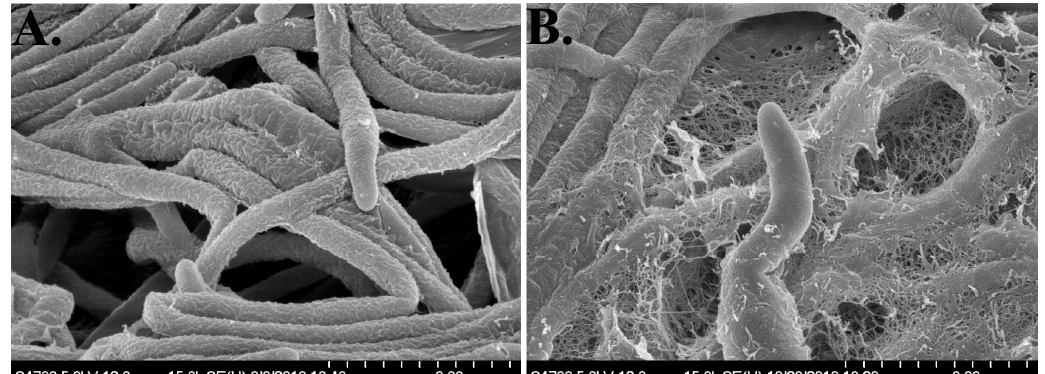
Figure 6. SEM images of actinobacterial-like structures from Iron Curtain Cave samples. ( A ) ICC1: Dense mass of rod-shaped and interwoven filaments with irregular rugose surface, Scale bars, 5 μ m; ( B ) ICC4: Mass of hyphae with smoother surface, Scale bars, 3 μ m.